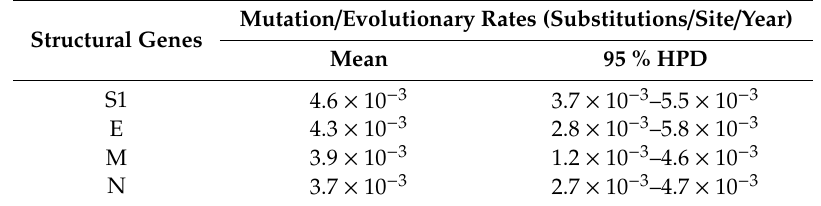
Table 5. Estimate of evolutionary rates (nucleotide substitutions / site / year) of IBV strains. Structural Genes